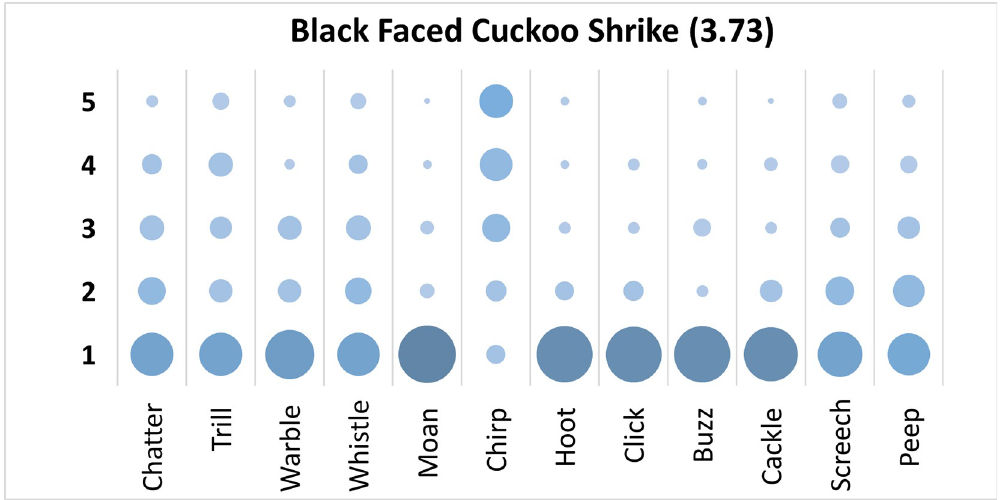
Fig 7. Count of participants’ sound descriptions scores for the Black Faced Cuckoo Shrike with confidence ratings in